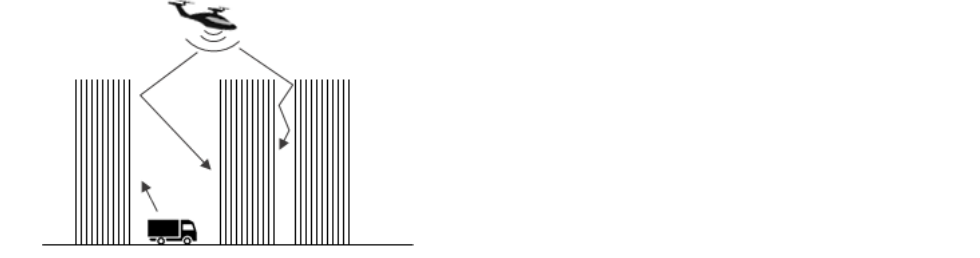
Figure 2. Prediction of noise distribution between UAM and automobiles. (Figure 2 is drawn by the author)